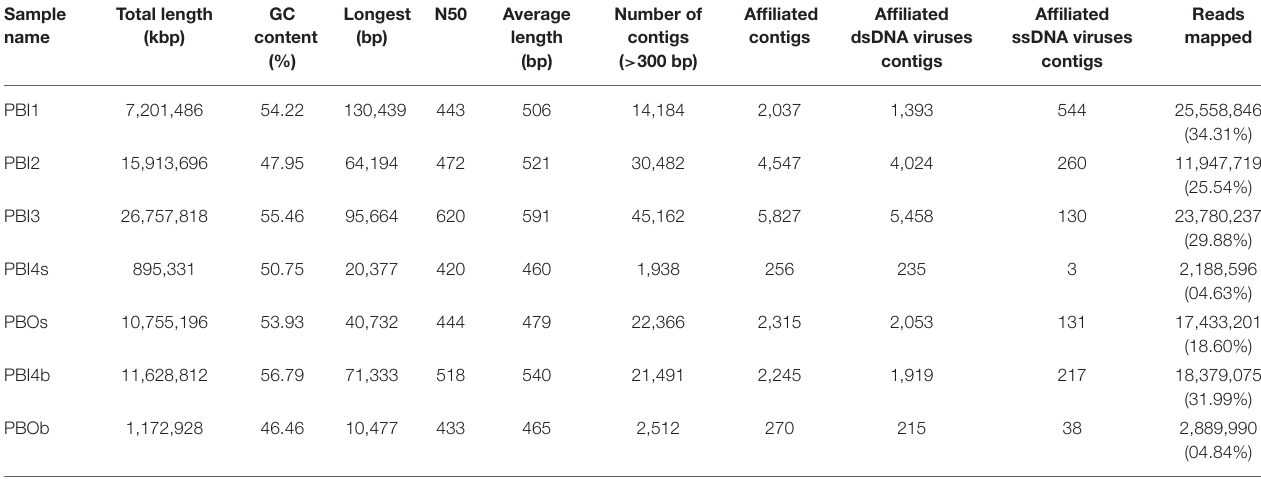
TABLE 2 | Data summary of seven viral metagenomic samples in the Prydz